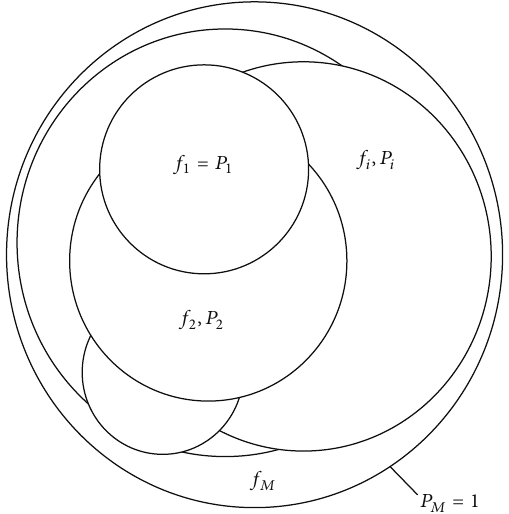
is the probability for nucle- M (the probability i